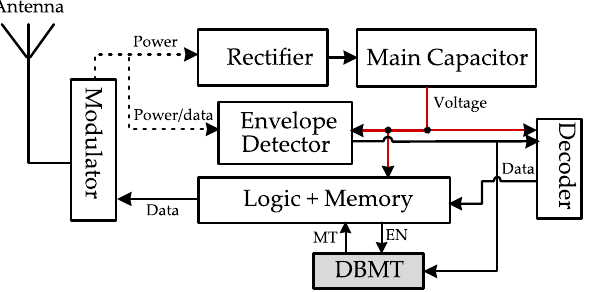
Figure 4. CWAD DBMT circuit location within typical passive RFID components.